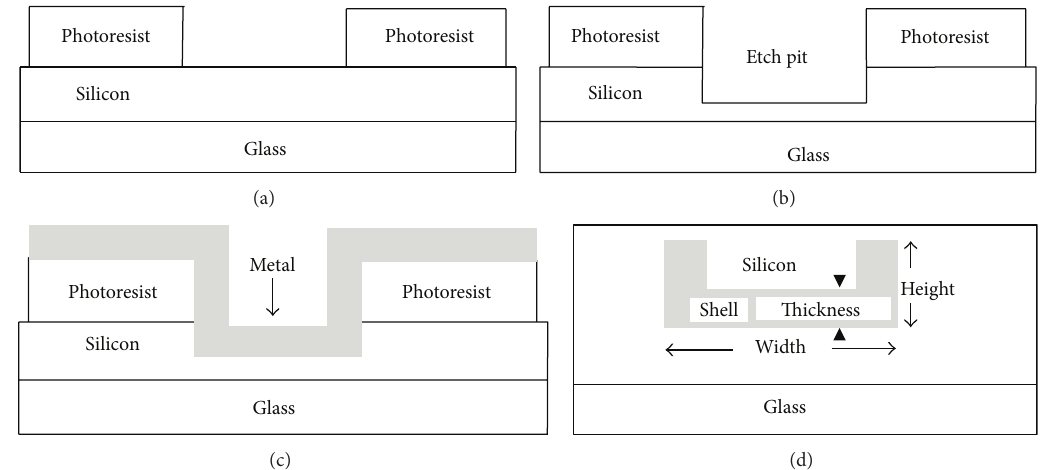
Figure 2: Suggested fabrication sequence for half-shell nanowires. (a) Lithography, (b) etching, (c) metal deposition, and (d) a half-shell nanowire after lift-off and silicon deposition.